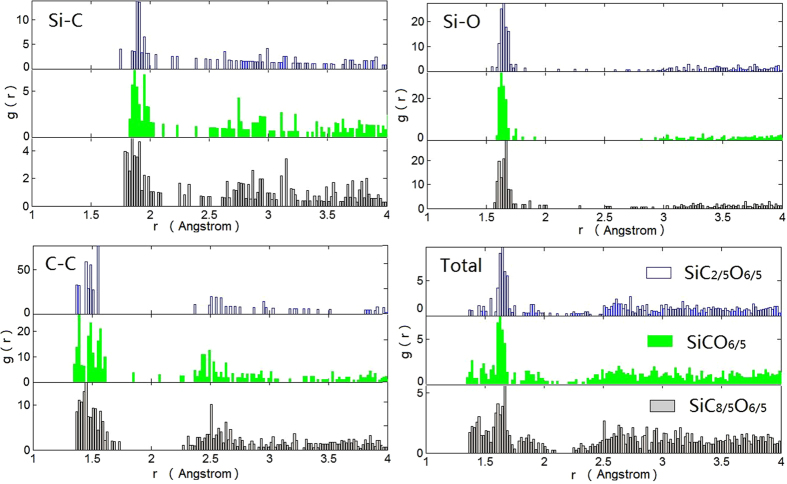
Radial distribution functions of the amorphous SiCxO6/5 structures.